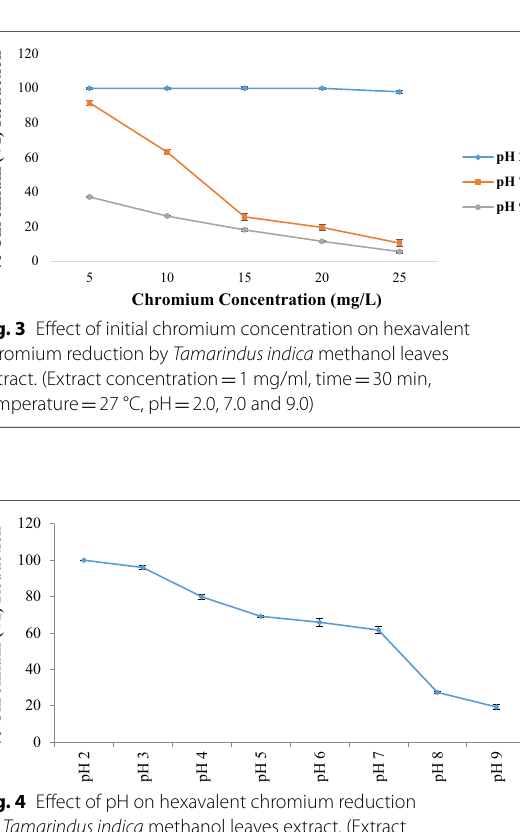
Fig. 4 Effect of pH on hexavalent chromium reduction by Tamarindus indica methanol leaves extract. (Extract concentration 1 mg/ml, chromium concentration = temperature